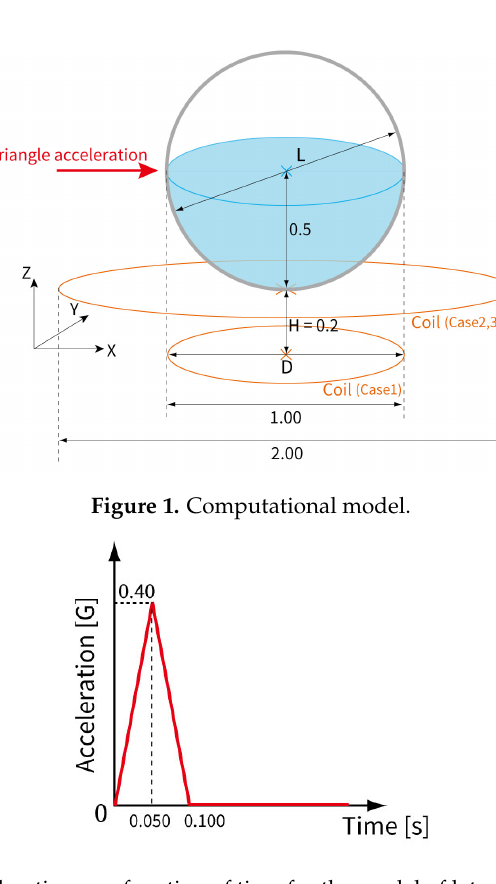
Figure 2. Acceleration as a function of time for the model of lateral impact